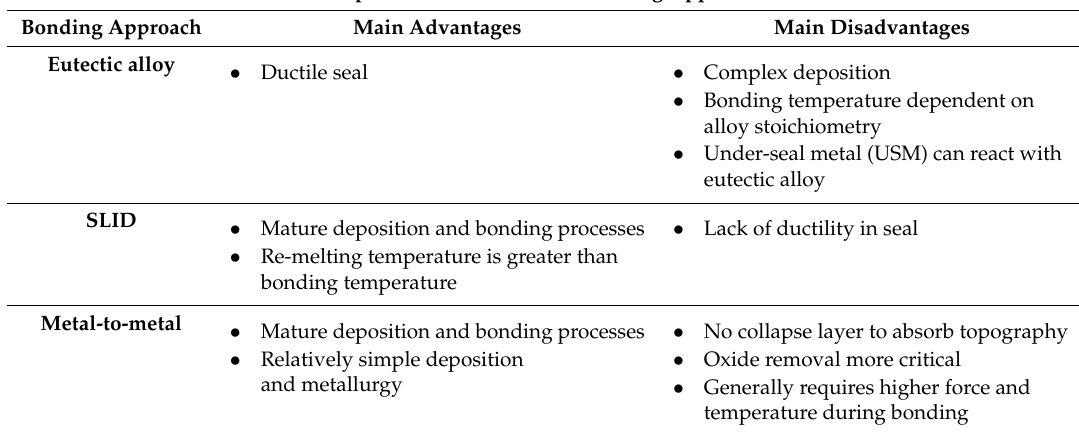
Table 2. Advantages and disadvantages of the various, metal-based, wafer-level vacuum packaging (WLVP)